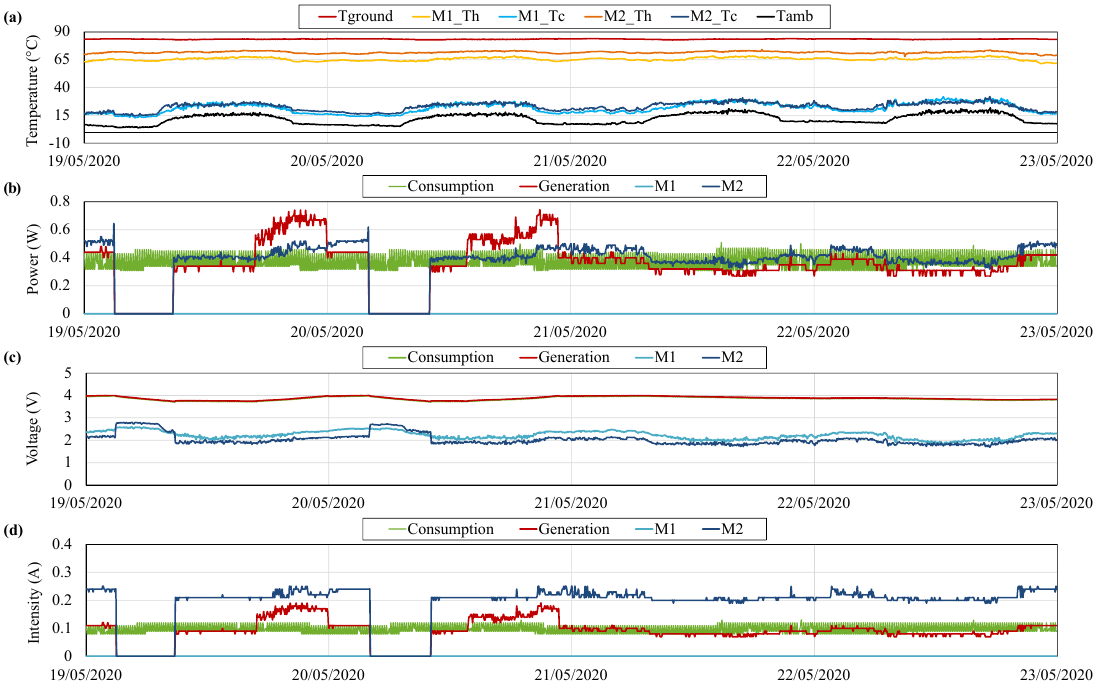
Figure 12. ( a ) Temperature, ( b ) power, ( c ) voltage and ( d ) intensity measurements during several hot